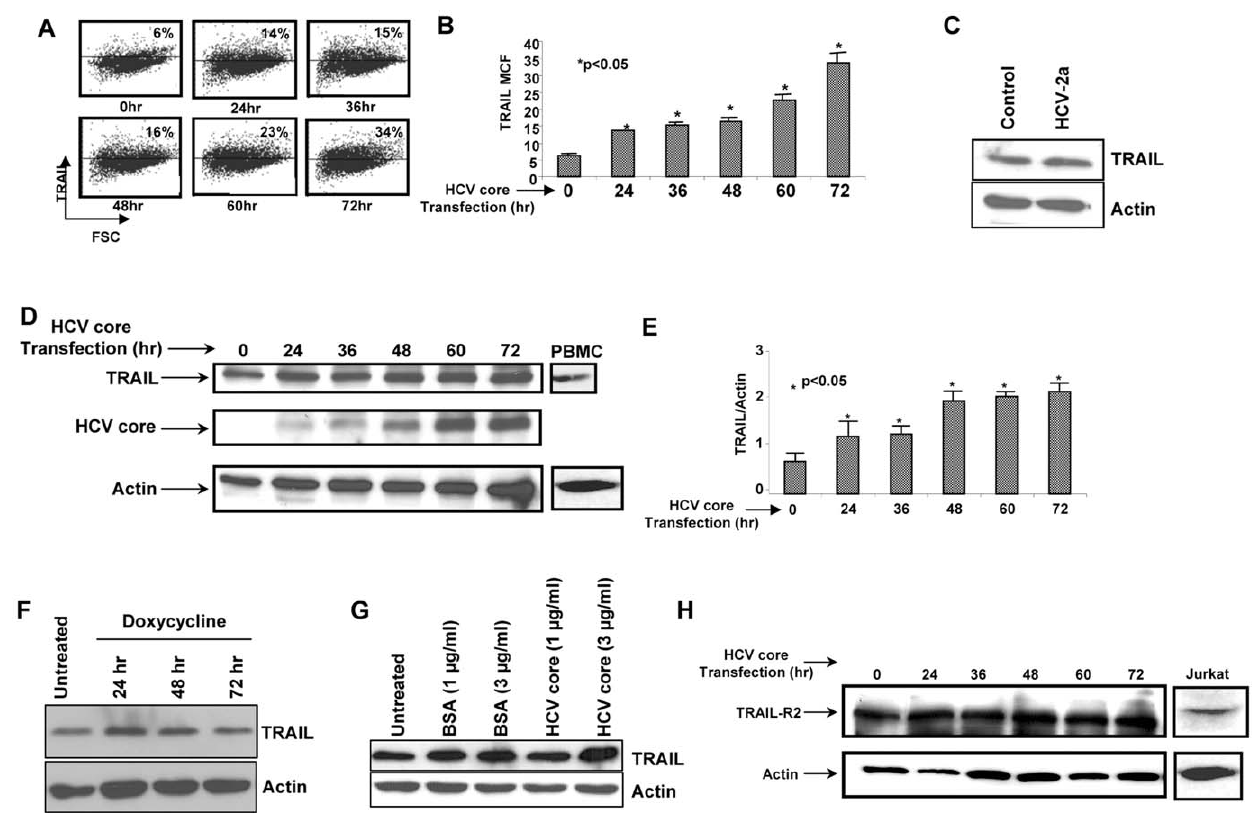
Figure 3. HCV core protein Increases TRAIL but not TRAIL-R2. (A and B) Huh7 cells were transfected with HCV core protein for increasing amounts of time and then analyzed for TRAIL expression by Flow cytometry or (D and E) Western blot. (C) Huh7.5 cells were infected with the JFH1 HCV genotype 2a and analyzed for TRAIL by Western blot. (F) Huh7 cells were treated with doxycycline for increasing amounts of time and analyzed for TRAIL by Western blot (G) Huh7 cells were treated with increasing concentrations of soluble HCV core protein or control and analyzed for TRAIL by Western blot (H) In parallel HCV core transfected Huh7 cells were analyzed for TRAIL-R2 expression by Western blot.